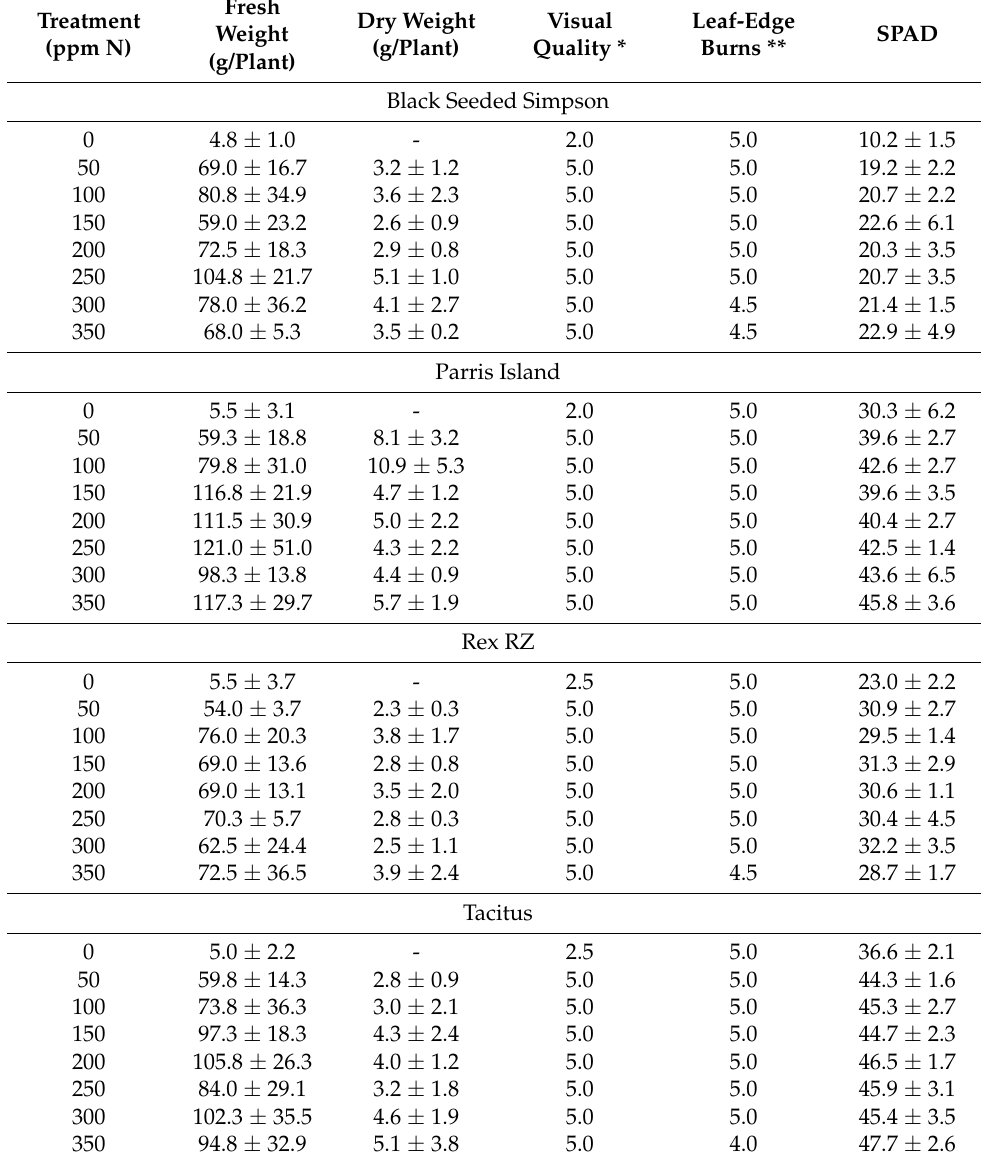
Table 1. Influence of nutrient concentrations on the growth of four different lettuce cultivars in hydroponic culture.